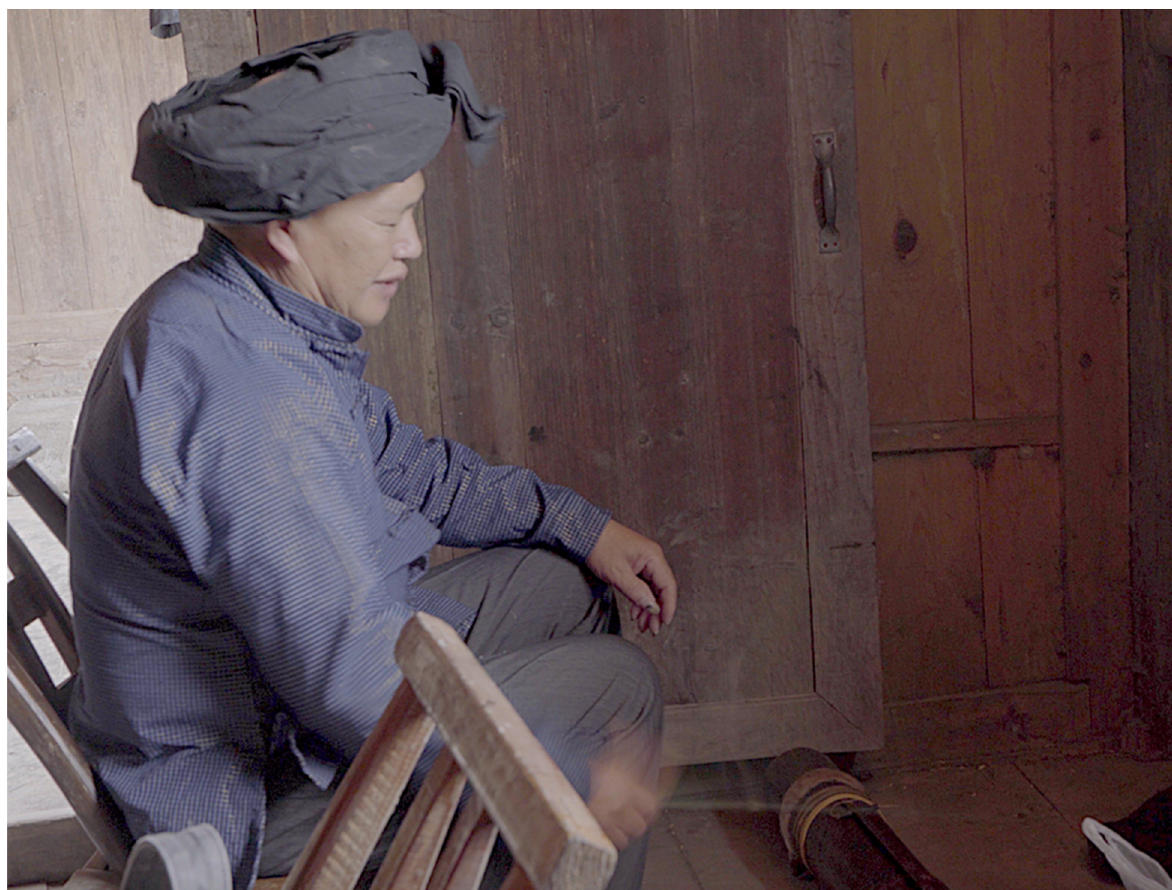
Figure 11. Badai Shi Changwu playing the zhutuo and chanting to call and welcome helping spirits into the house. (Photo: Thomas Riccio).